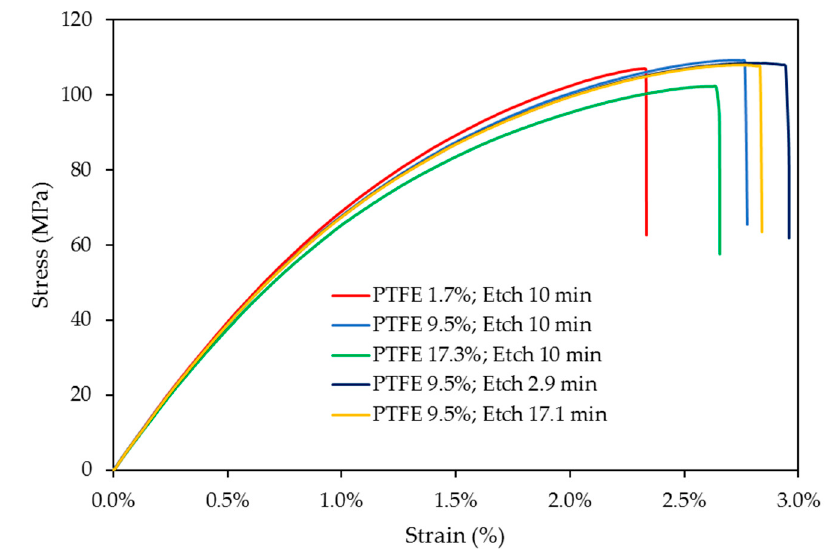
Figure 3. Stress vs. strain curves comparing effects of PTFE content and etch time on POM composites.